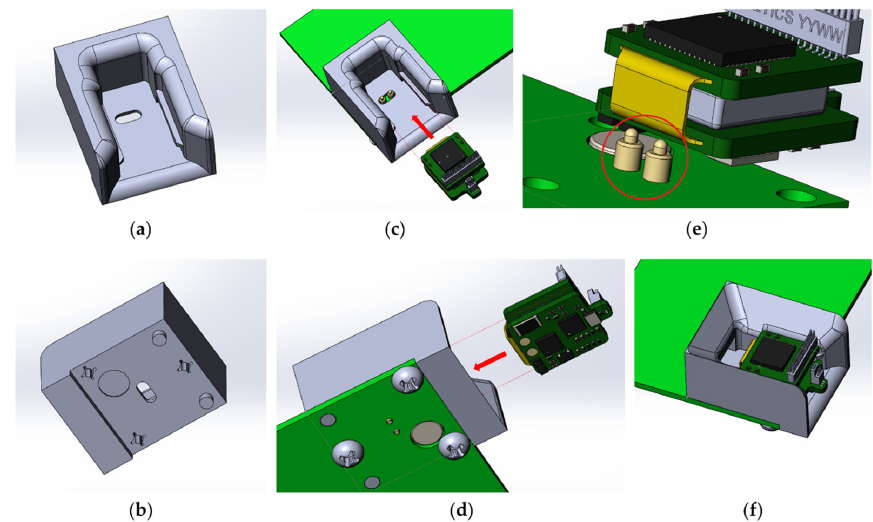
Figure 8. Slot for inserting the wireless module: ( a ) top view, ( b ) bottom view; location of the wireless module for fixing in the slot of the base station: ( c ) top view, ( d ) bottom view, ( e ) dedicated spring loaded pogo pin for charging the wireless module, ( f ) wireless module inserted into the slot of the base station.